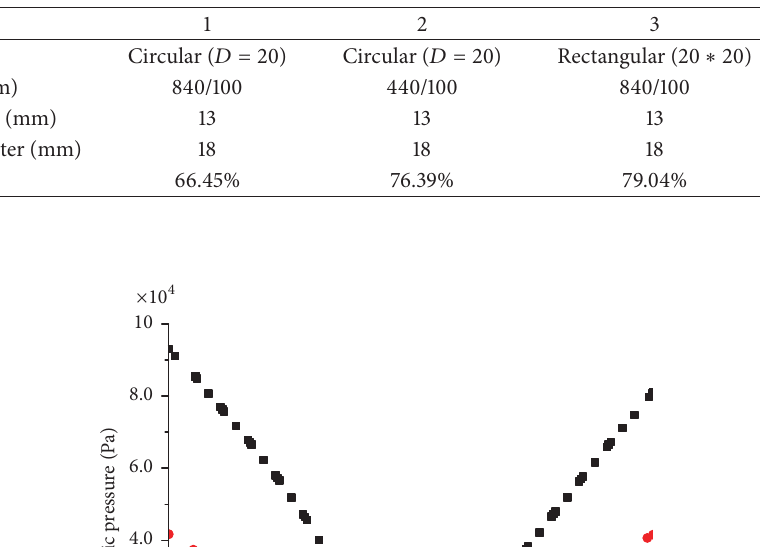
Table 2: The comparison of separation efficiency with optimized structure.